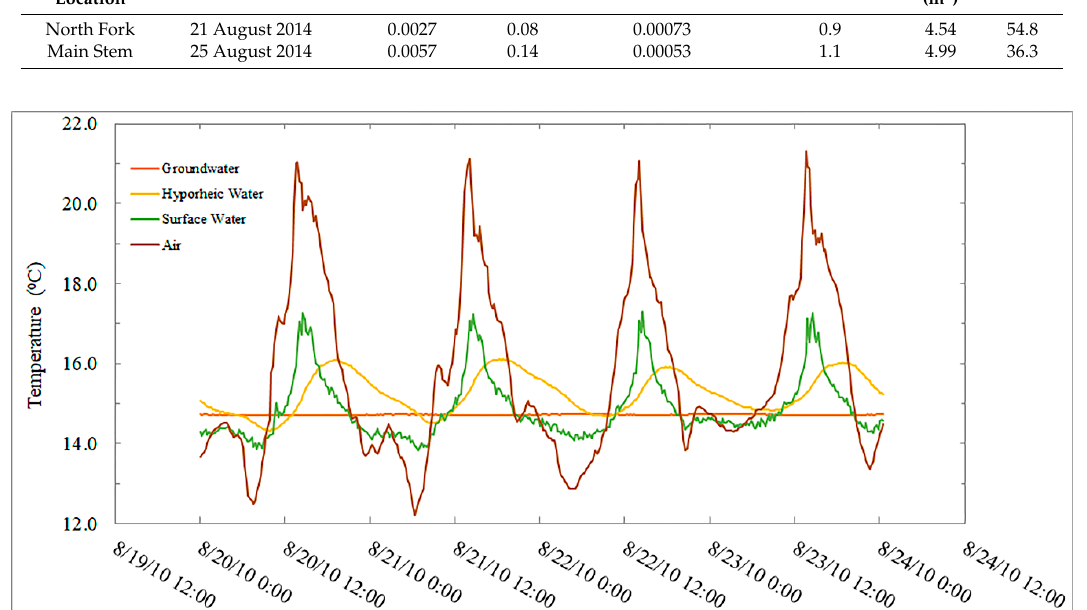
Figure 3. Observed air, surface, hyporheic and groundwater temperatures on Little Creek at location 390 m from 21 to 25 August 2014. Groundwater temperature was measured at a nearby spring.